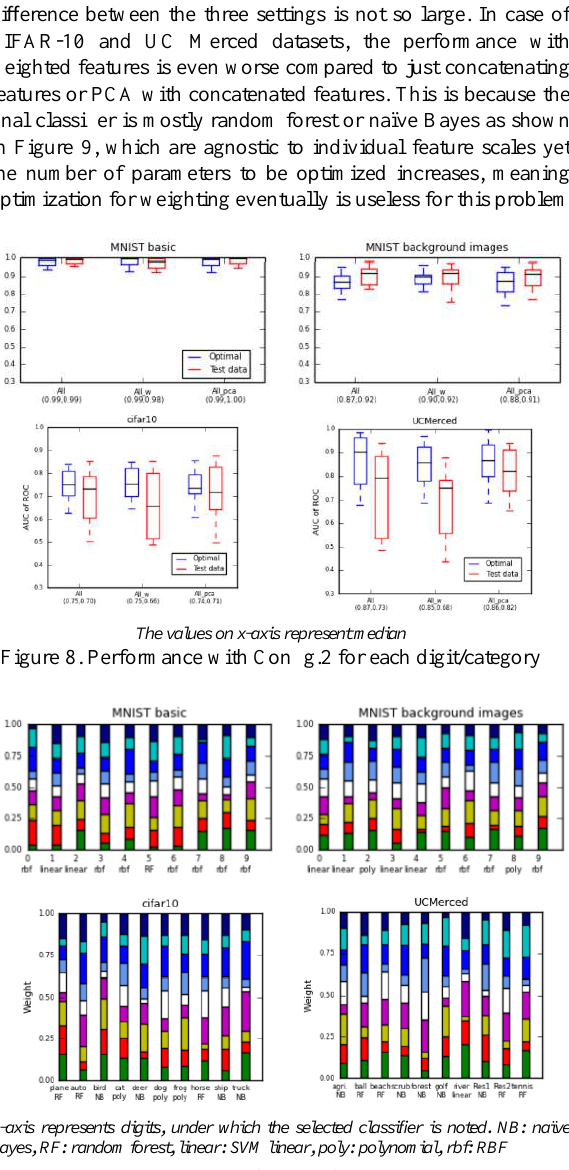
Figure 9. Weight value on features for each